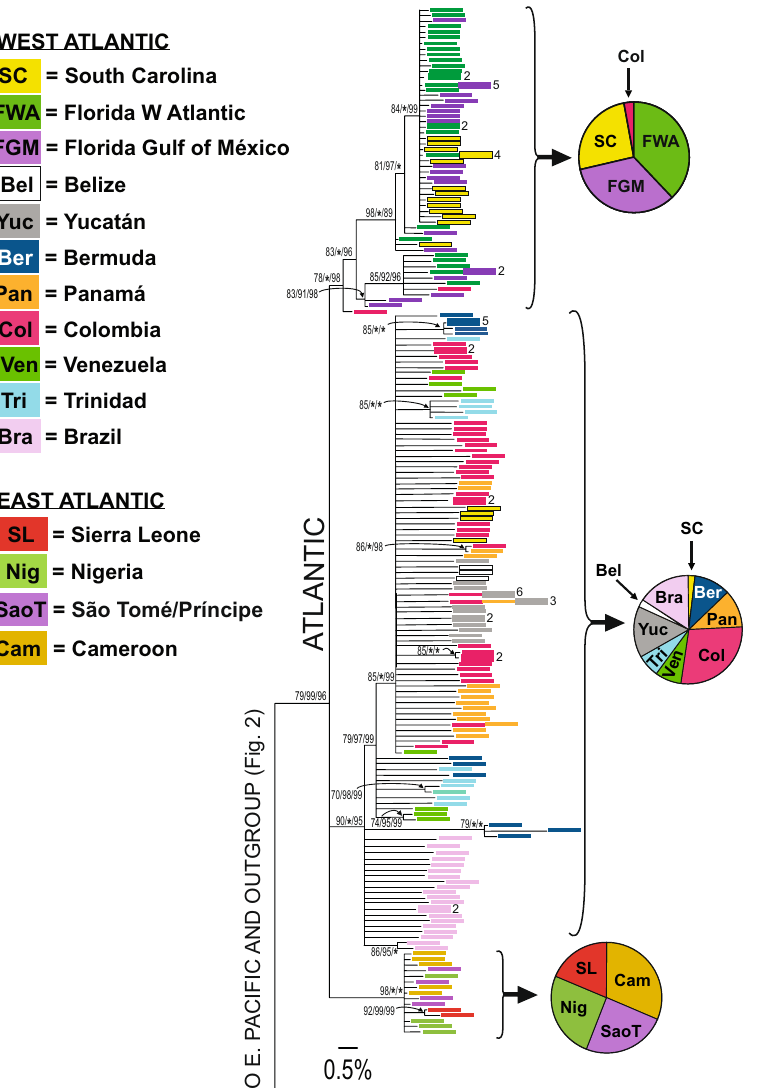
Figure 1. Gene genealogy of unique Atlantic haplotypes of concatenated 16S and two regions of COI of Petrolisthes armatus , showing a consensus tree from RAxML, MrBayes, and BEAST. Pacific haplotypes and outgroup are shown in Fig. 2. Colour bars indicate locality. Bars are followed by numbers when 2 or more identical sequences were found in each locality. Pie diagrams indicate the proportion of haplotypes from a particular locality encompassed in each clade. Values next to nodes indicate Maximum Likelihood/MrBayes/ BEAST support in this order. * = 100% Bayesian posterior probability support. Nodes with less than 70% support in RAxML or less than 85% in MrBayes and BEAST have been